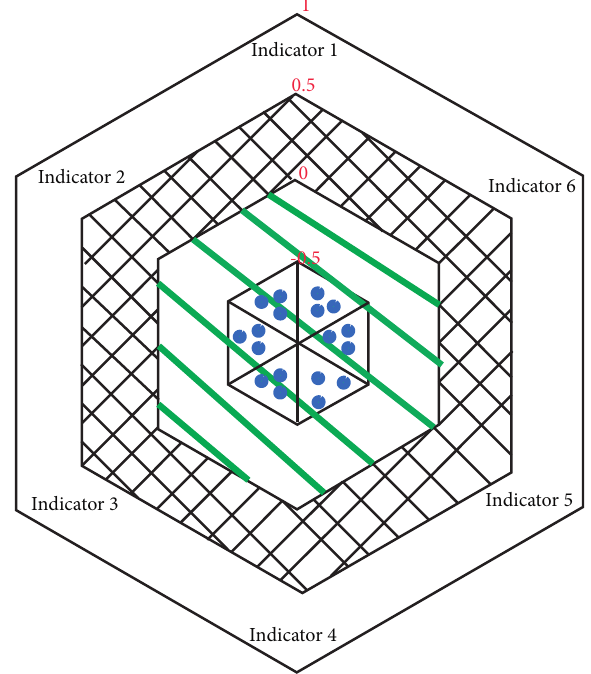
Figure 3: Graphical index method of full arrangement polygon.